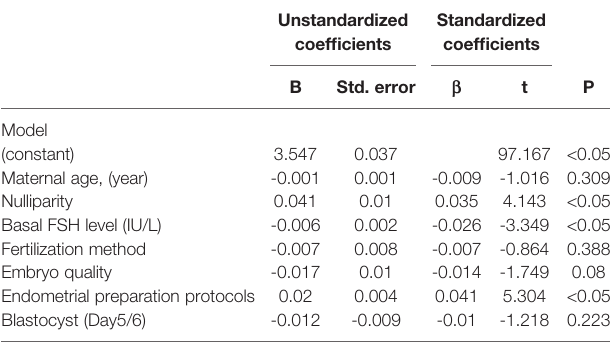
TABLE 4 | Multiple regression analysis of potential confounders associating with neonatal birth weight.